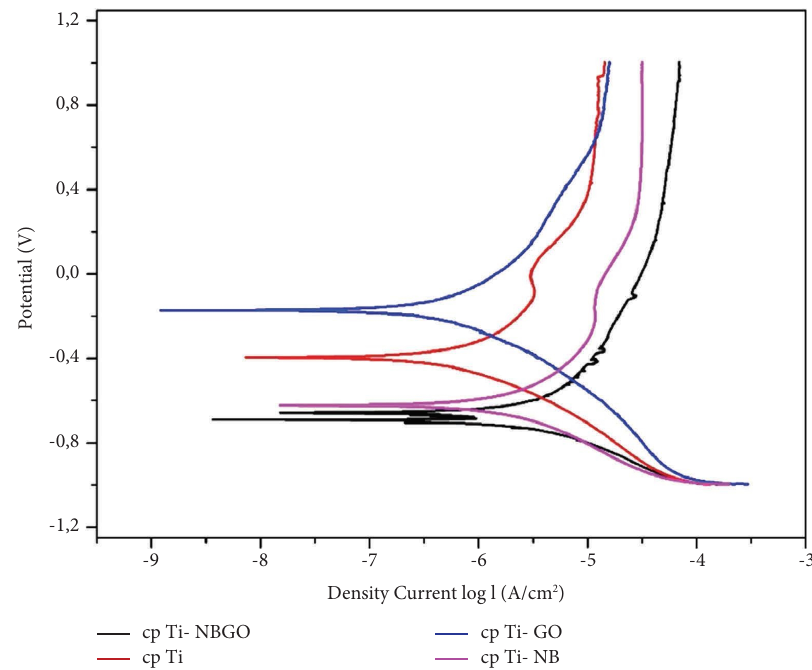
Figure 10: Polarization curve for cp Ti, cp Ti-GO, cpTi-NB, and cp Ti-NBGO in a physiological solution containing 0.9%